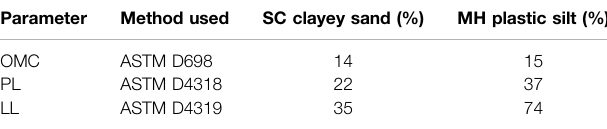
TABLE 1 | Moisture contents of two soil